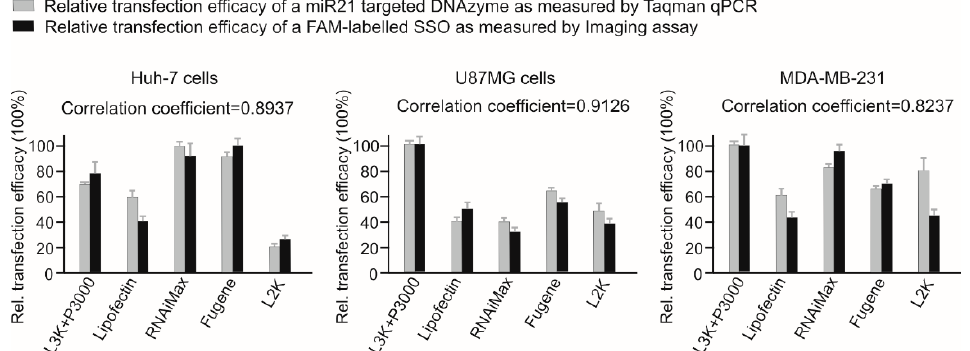
Figure 1. Comparison of two methods for efficacy assay of different transfection reagents using SSO. This assay was conducted by two independent experiments as indicated. The data from both tests were normalized by setting the highest transfection data as 100%. L3K: Lipofectamine 3000, L2K: Lipofectamine 2000.